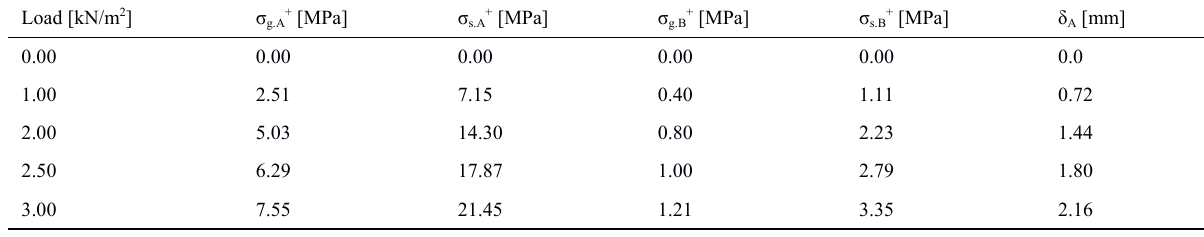
Table 9: Vertical displacement and stresses obtained from the numerical